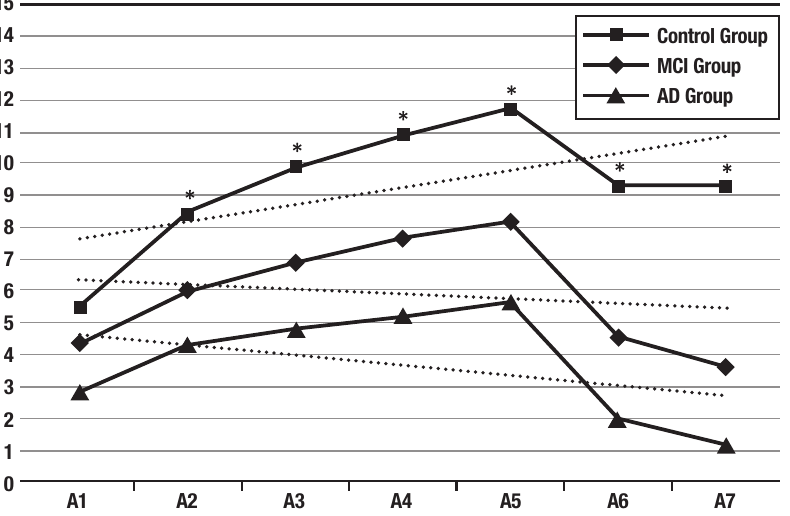
Figure 1. Performance curve for all three groups across RAVLT trials. Dotted lines show the linear tendency of each group serial recall